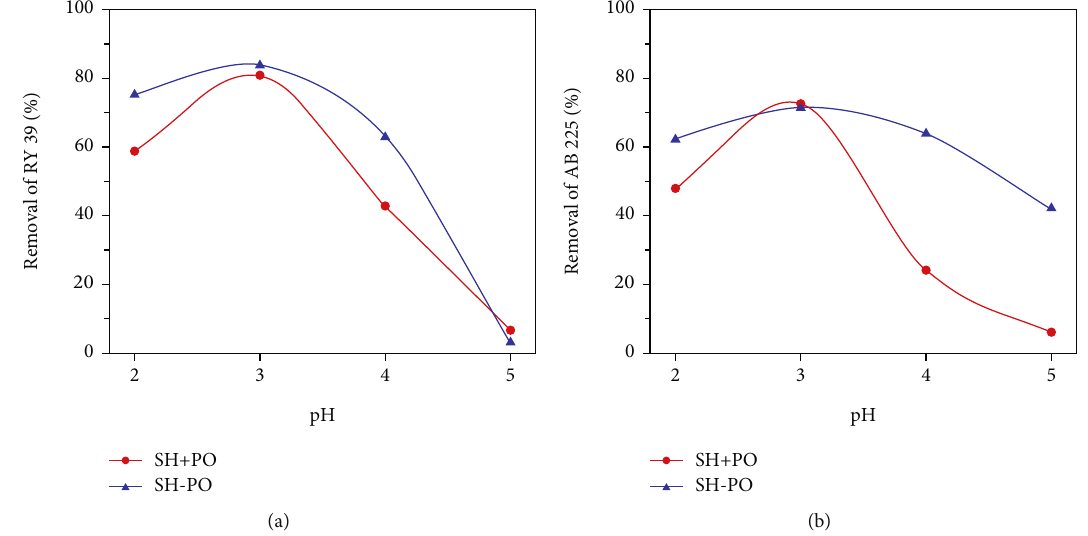
Figure 6: E ff ect of solution pH on (a) RY 39 and (b) AB 225 removal by soybean